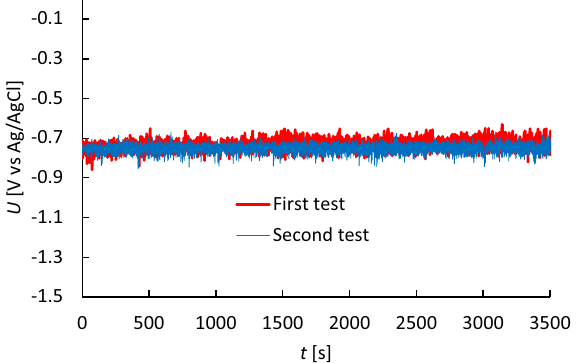
Figure 3. Open circuit potential test of the aluminium anode. Two tests of two aluminium foil samples are performed for